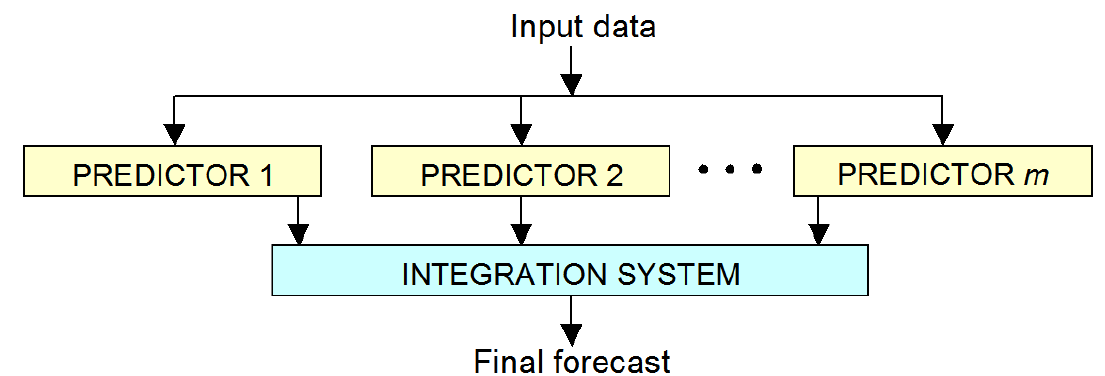
Figure 9. General structure of ensemble methods.